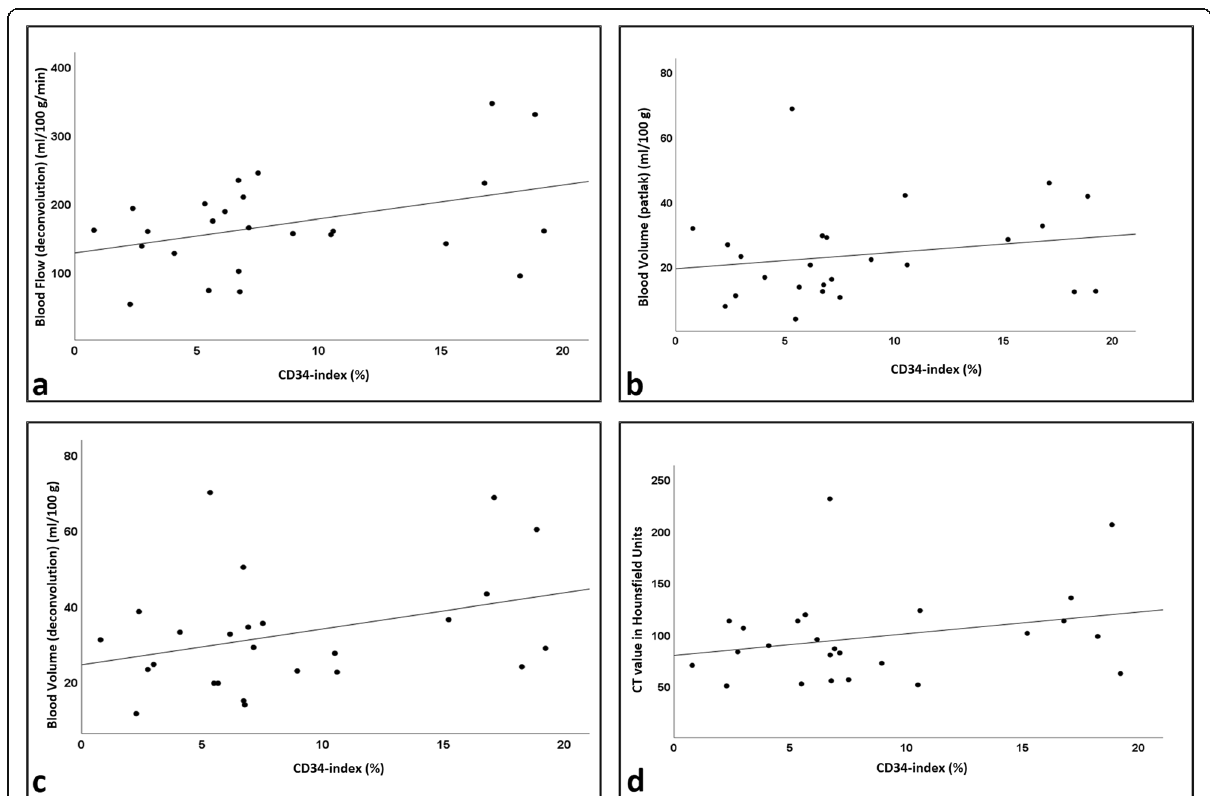
Fig. 4 Plots illustrating no correlation between CD34-index in tumor outlines and (a) BF deconv , (b) BV Patlak , (c) BV deconv , and (d) HU, respectively at baseline. BV deconv Blood volume (deconvolution), BV Patlak Blood volume (Patlak), BF deconv Blood flow (deconvolution), HU Hounsfield